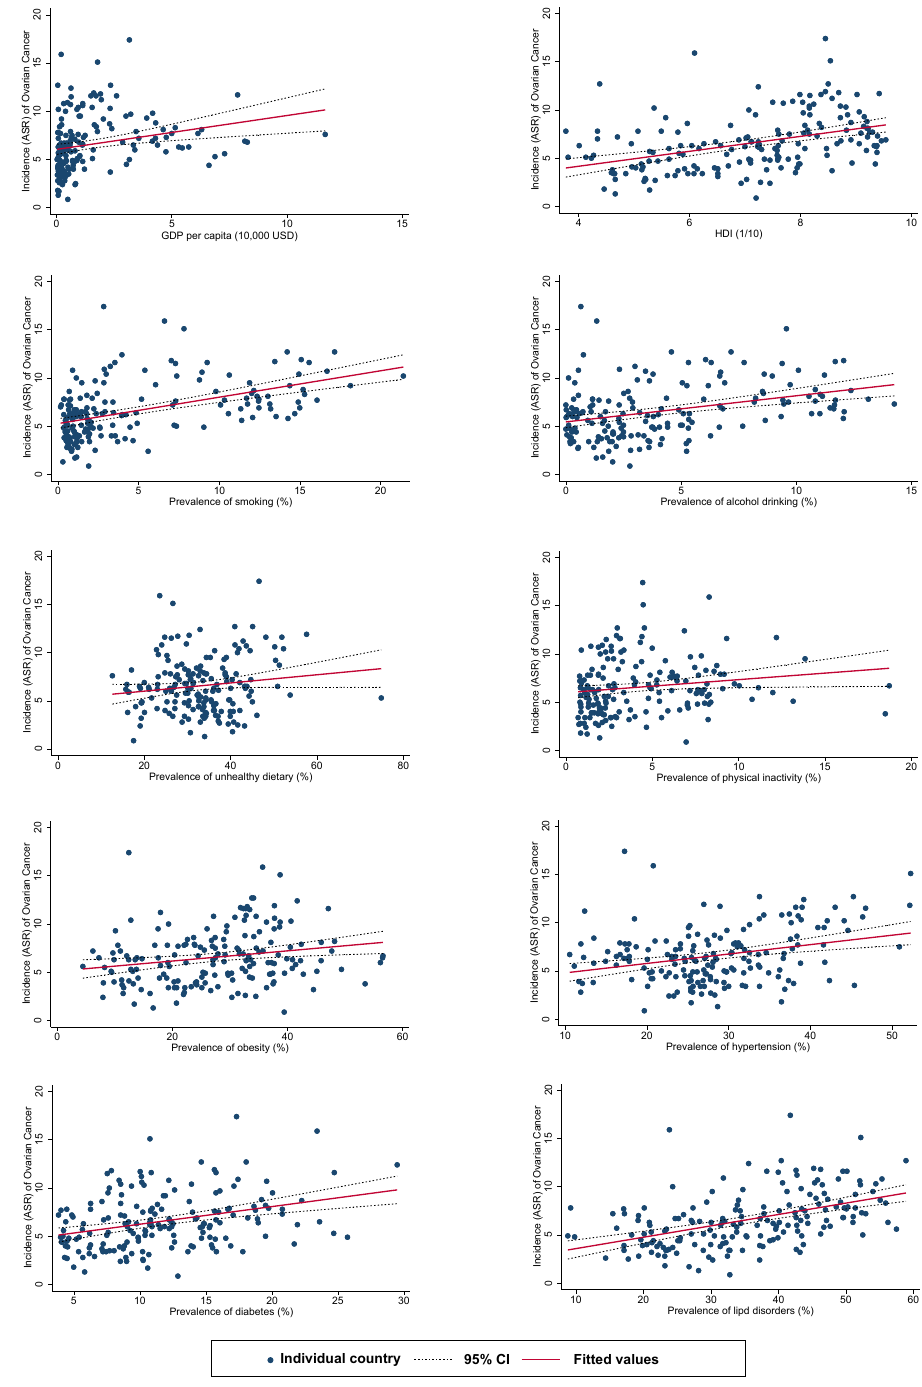
Figure 2. Associations between risk factors and the incidence of ovarian